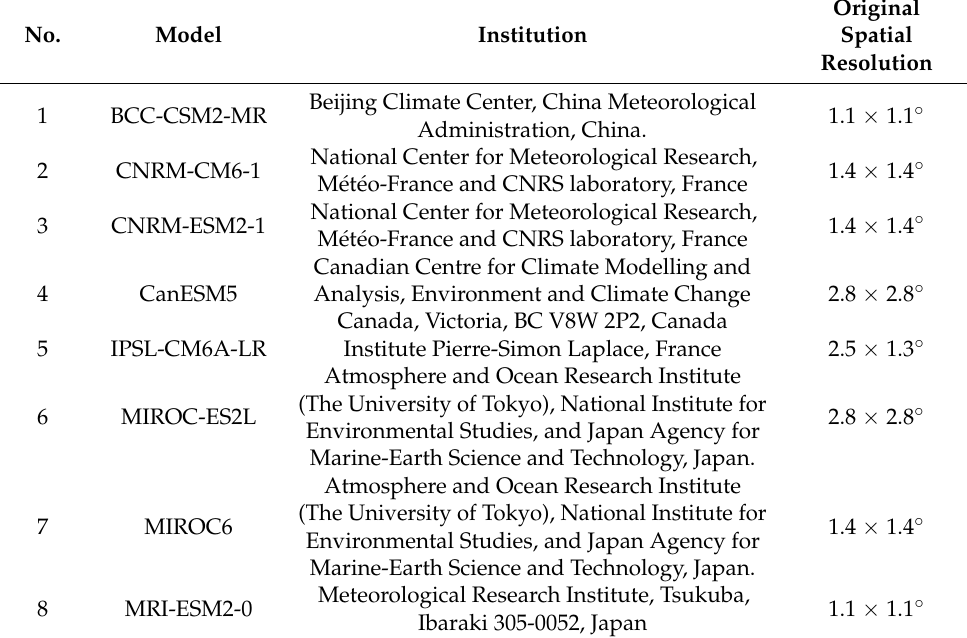
Table 2. Overview of the